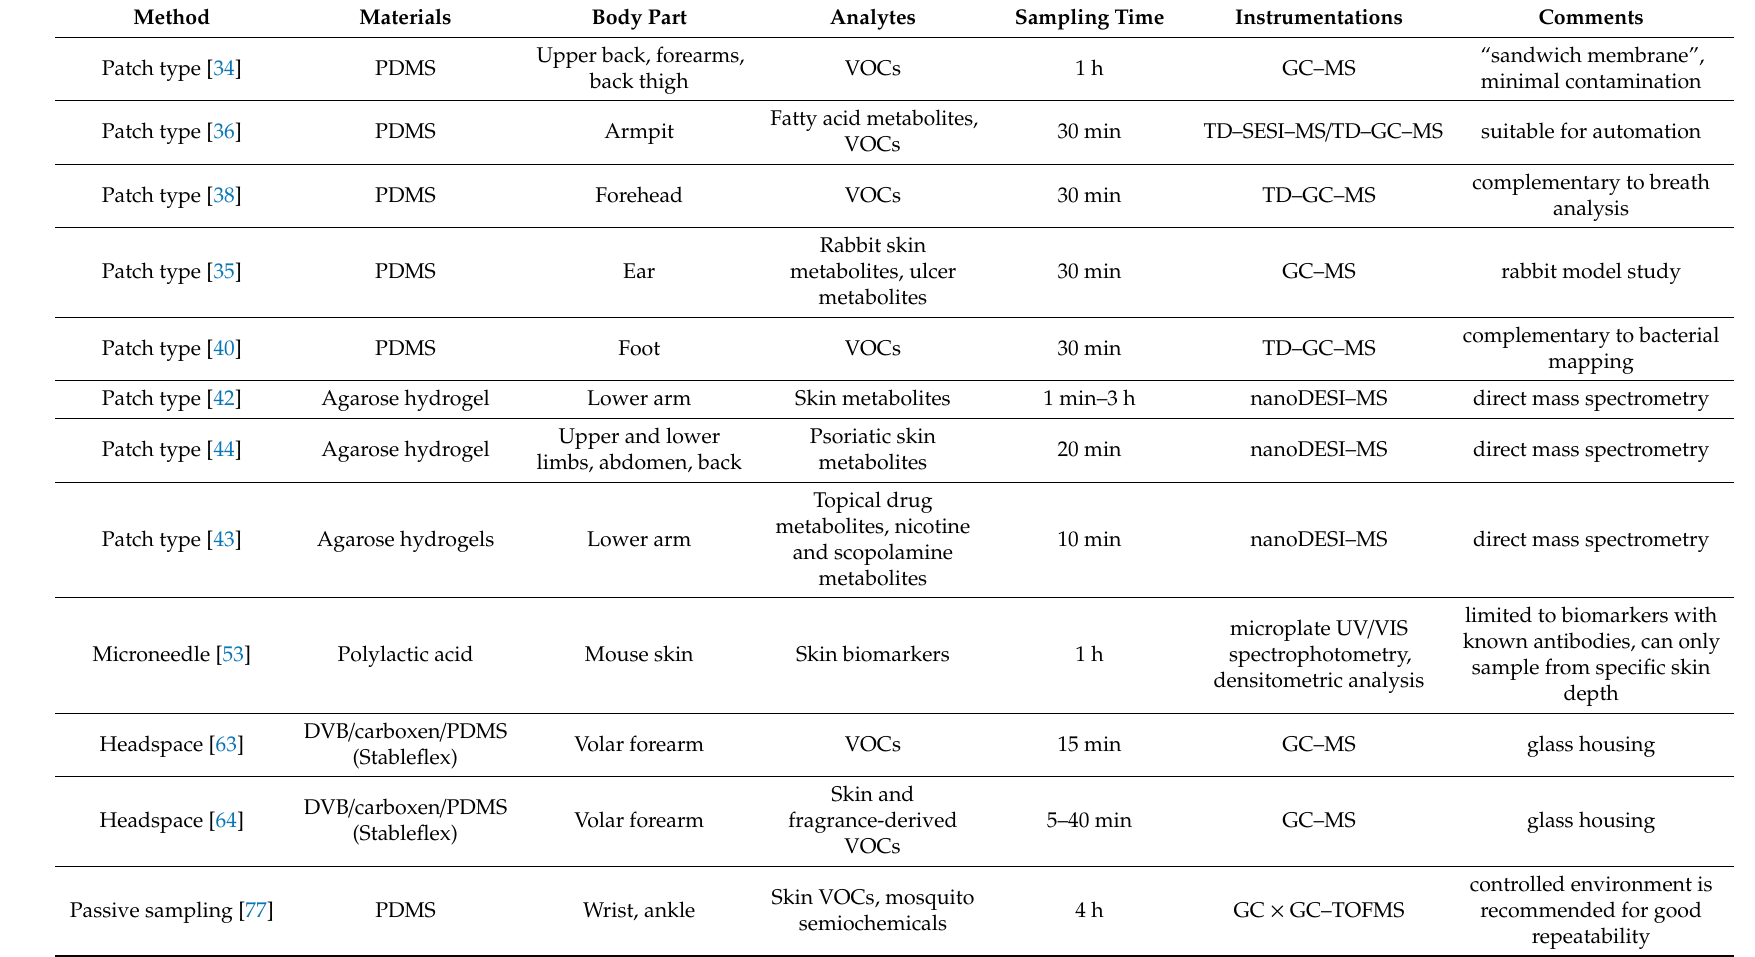
Table 2. Summary of reviewed skin sampling